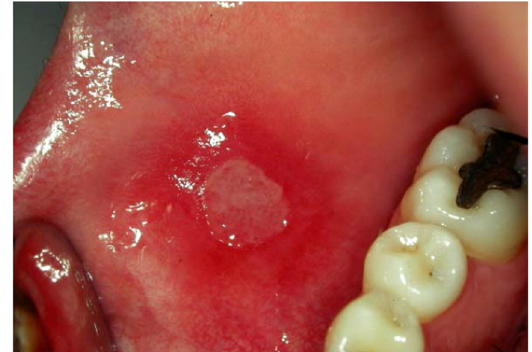
Figure 1. Aphthous lesion in an adult patient.